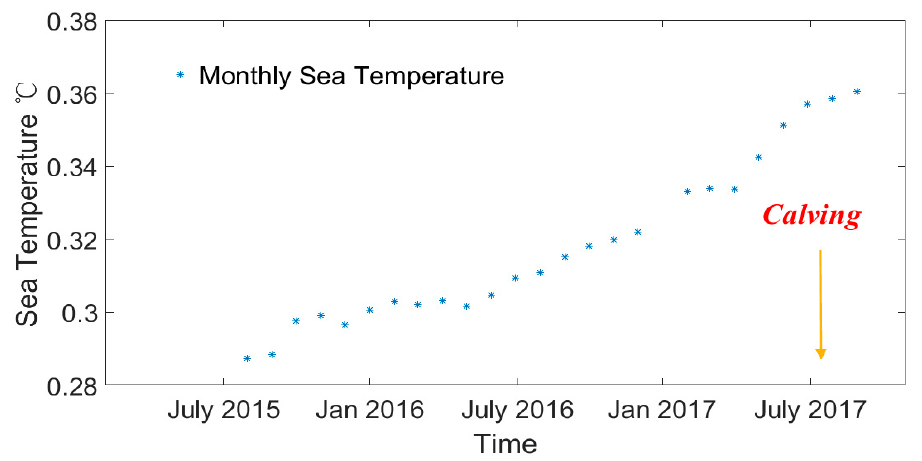
Figure 11. Monthly series of ocean temperature below 450 m at the Petermann ice shelf from 2015 to 2017 at position (59.9671 W, 80.5804 N) from Andreas Muenchow.